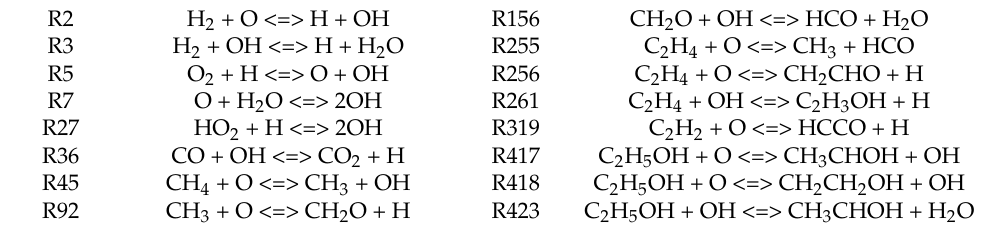
Table 1. Reaction summary of O or OH production rates.